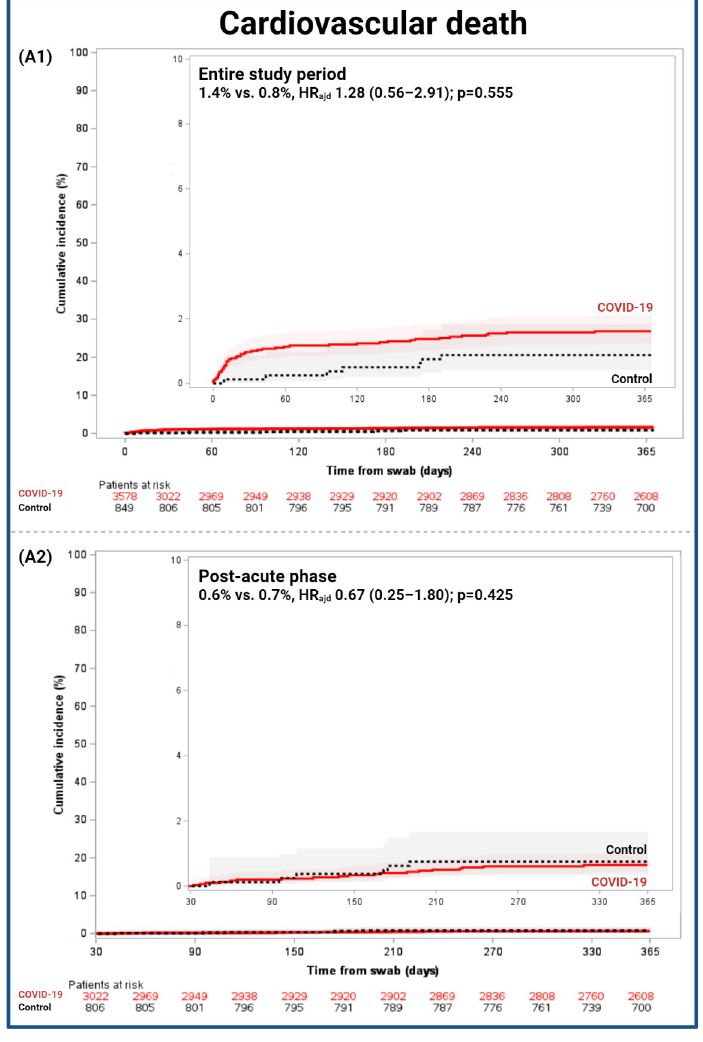
Fig 1. Cumulative incidence of cardiovascular death in the COVID-19 and control cohorts. Cumulative 1-year incidences are shown with Kaplan-Meier event rates with 95% CI. (A1) Entire study comprised from 0–365 days and (A2) post-acute phase from 31–365 days. Adj HR, adjusted hazard ratio; 95%CI, 95% confidence interval.